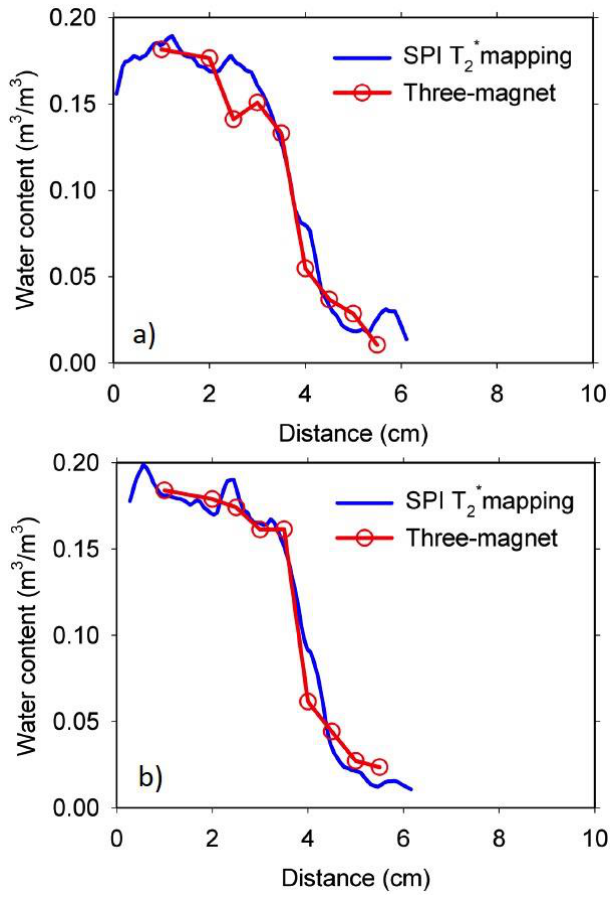
Figure 6. Water content distribution from SPI T 2 * mapping and CPMG signal intensity for the 0.35 w/c ratio, 100 mm long duplicate mortar samples ( a , b ) at four days of water absorption. The T 2 * was about 158 μs.